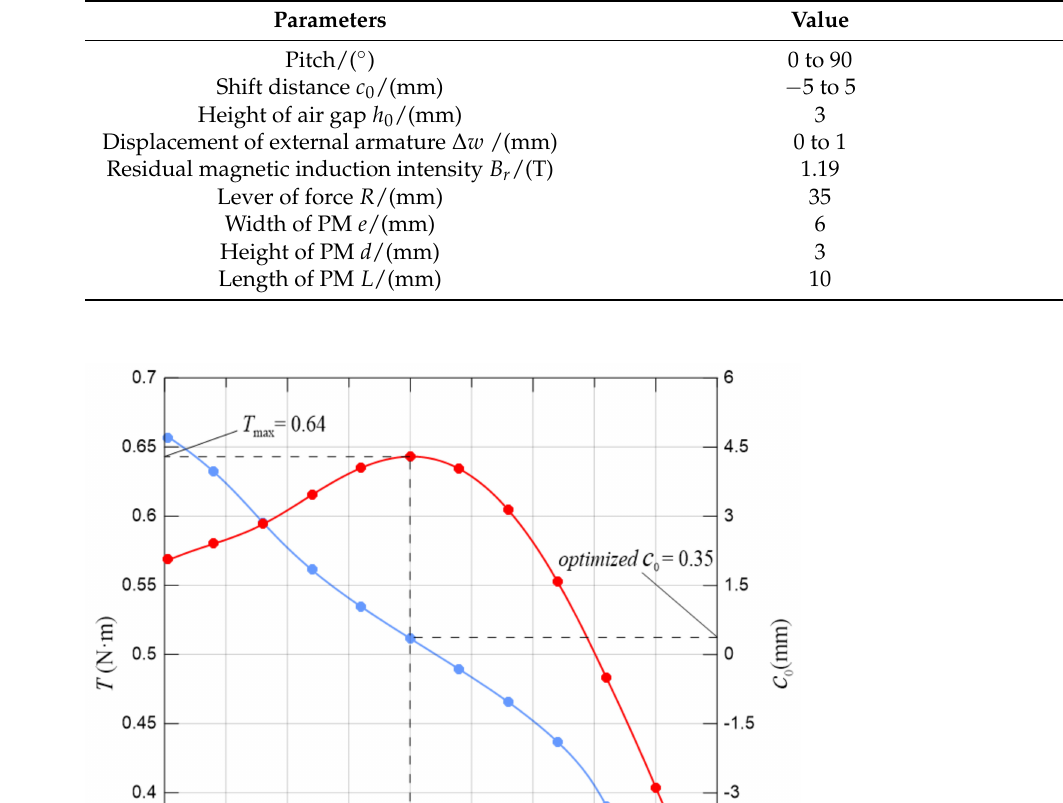
Table 3. Key structural parameters used in the parametric analysis.